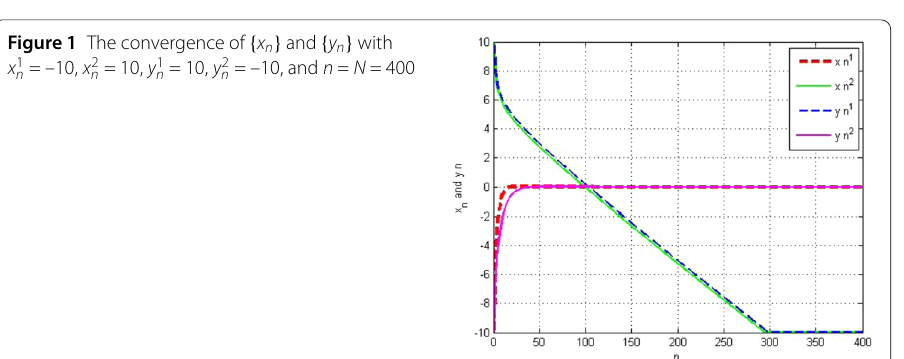
Figure 1 The convergence of { x n } and { y n }